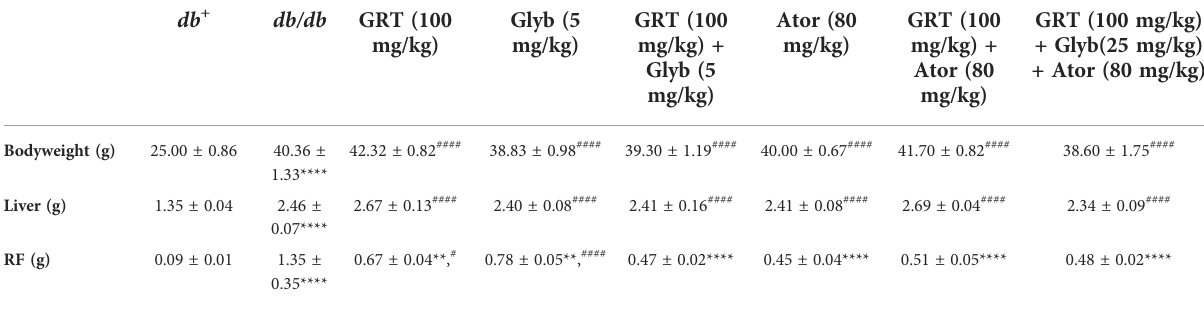
TABLE 1 Body, liver and retroperitoneal fat weights of mice treated with GRT, glyburide, and atorvastatin for 5